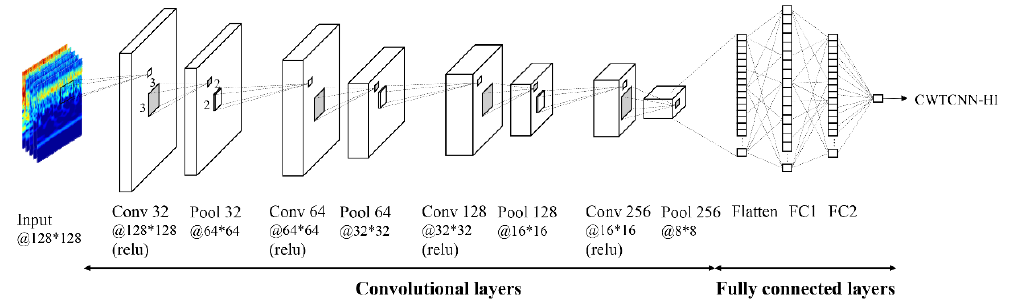
Figure 3. Proposed CWTCNN-HI model for Remaining Useful Lifetime (RUL) estimation.